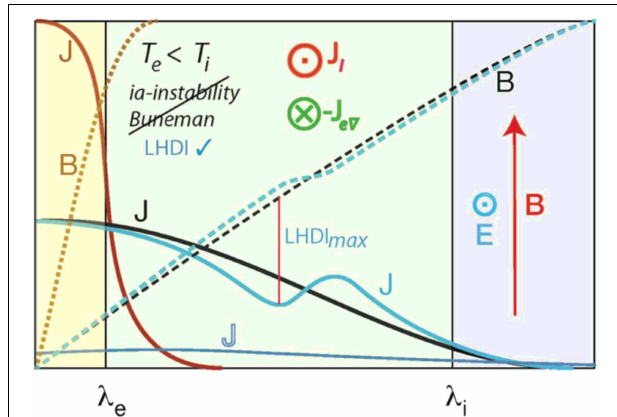
FIGURE 1 | Schematic of the three cases of current sheets J of different widths but same strength. Open J: Broad current sheet, width > ion inertial length λ i . The current is distributed, density gradients are very weak. Such current sheets are either stable or undergo mechanical turbulence when evolving large-scale eddies. Black J: Current sheet of intermediate width λ e < width < λ i between electron and ion inertial scales (green background). In such layers ions are non-magnetic, while electrons are magnetized. The current is carried by nonmagnetic ions (red J i ) which are accelerated in the convection electric field ( E ). Electron-gradient-drift current (green J e ∇ of magnetized electrons in current-density gradient are the second current source. In such sheets not ion-acoustic or Buneman instabilities can be generated. They are unstable with respect to the Lower-hybrid-drift instability (LHDI) which maximizes in the steepest density gradient (red vertical bar) and may cause current bifurcation shown as the blue current profile corresponding to a weak deformation of magnetic field strength (dashed blue line) and a weak antiparallel magnetic component only. Brown J : Narrow current sheets of widths comparable to λ e have very steep current density profile and are carried mainly by non-magnetized electrons. Such sheets are subject to several kinds of electron inertia driven instabilities causing electron viscosity. Magnetic fields in such sheets are antiparallel across the sheet and thus unstable to prompt collisionless